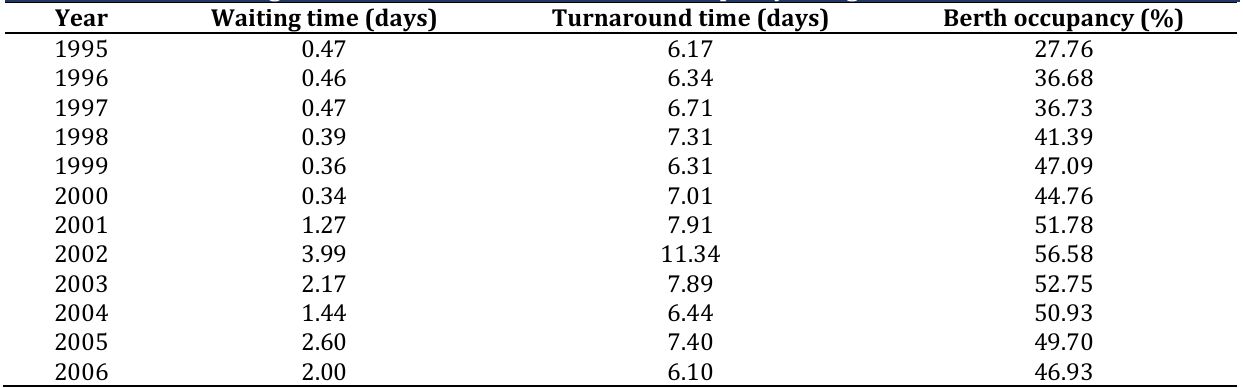
Table 4: Overall waiting time, turnaround time and berth occupancy at Nigeria Ports